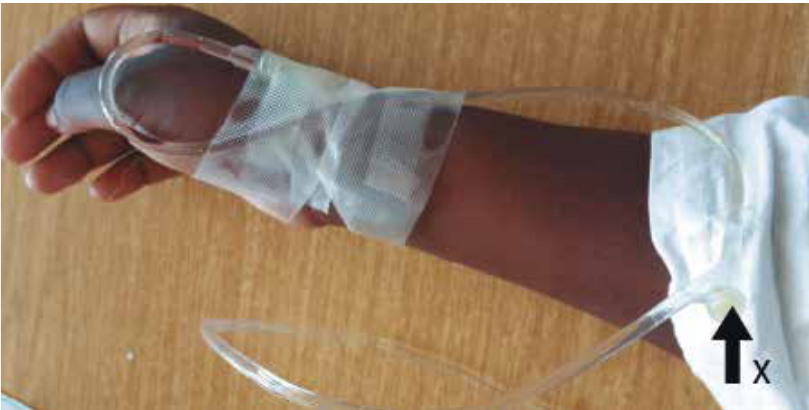
Fig. 1. Intravenous infusion set in use, showing an injection site for administration of supplementary medication. (X = injection site where an additional intravenous infusion set was